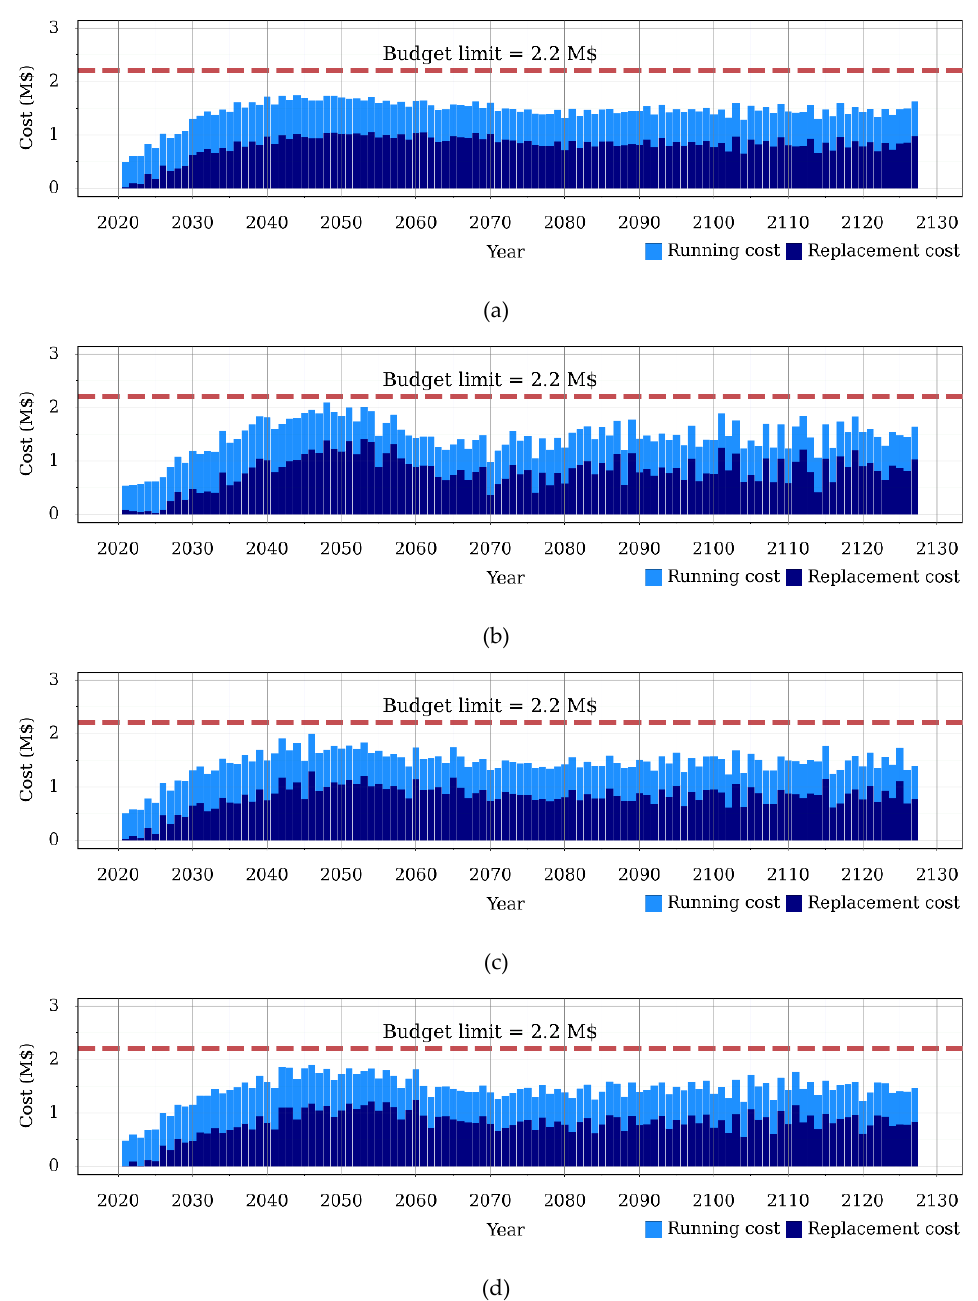
Figure 11. Future investment time series for Scenario 2: ( a ) Solution 1—min. SD of annual investment, ( b ) Solution 2—min. imposed LCC, ( c ) Solution 3—min. system age, and ( d ) Solution 4—knee-point.